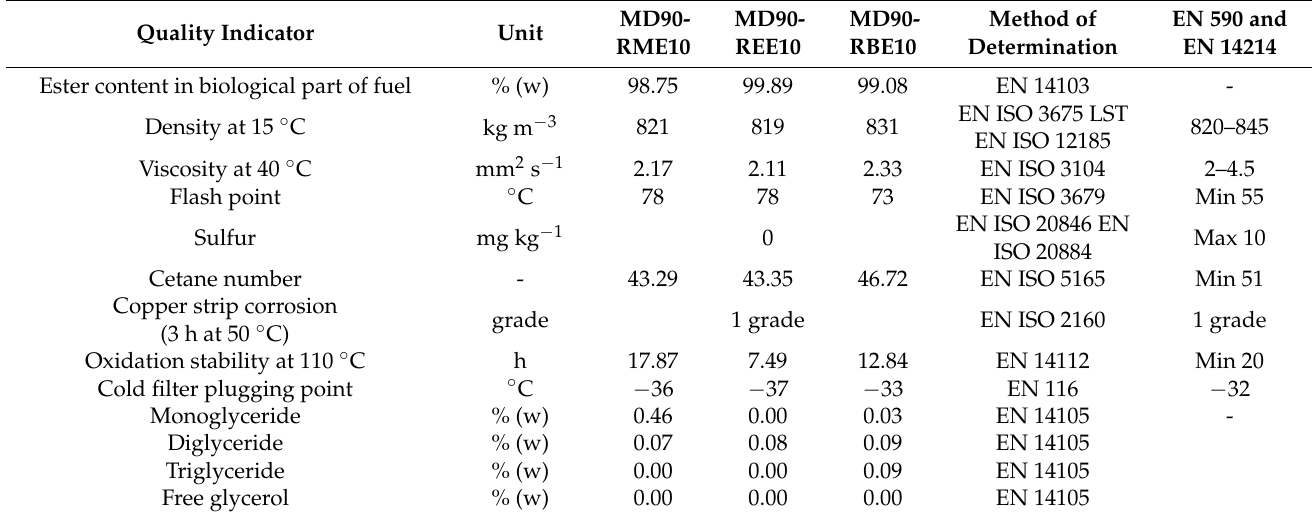
Table 2. Quality indicators of fuel